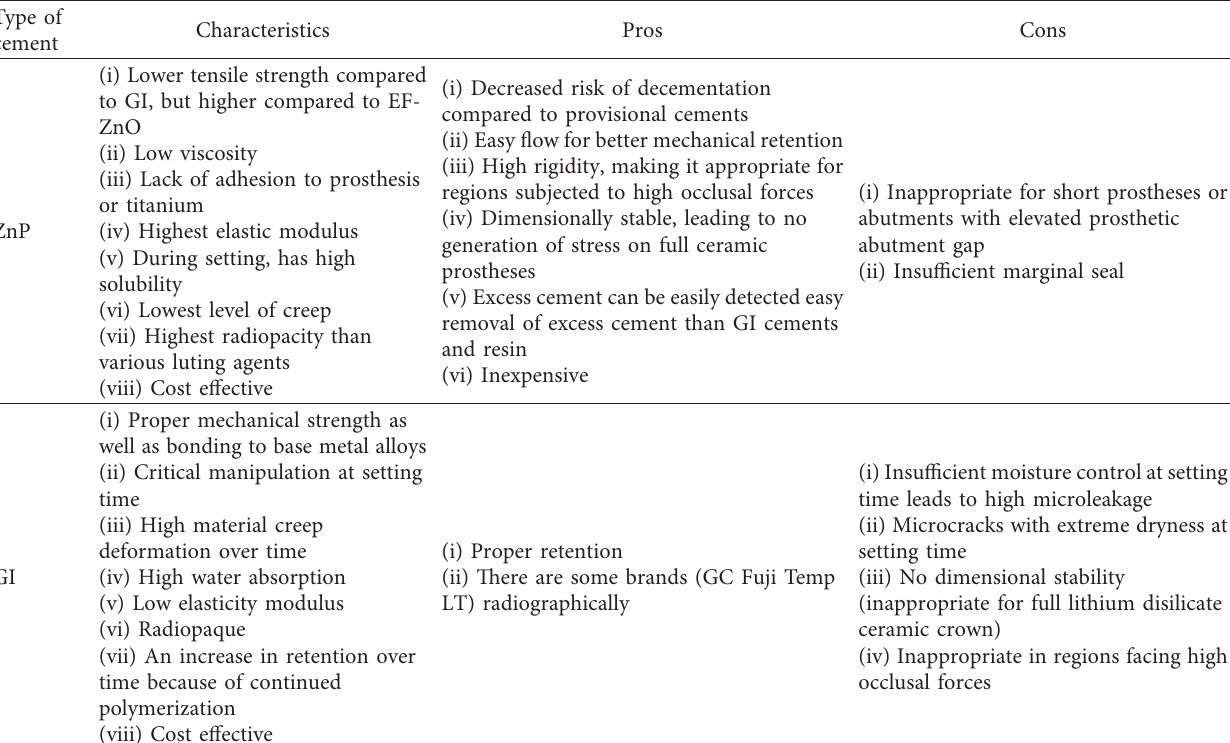
Table 2: Semipermanent cements